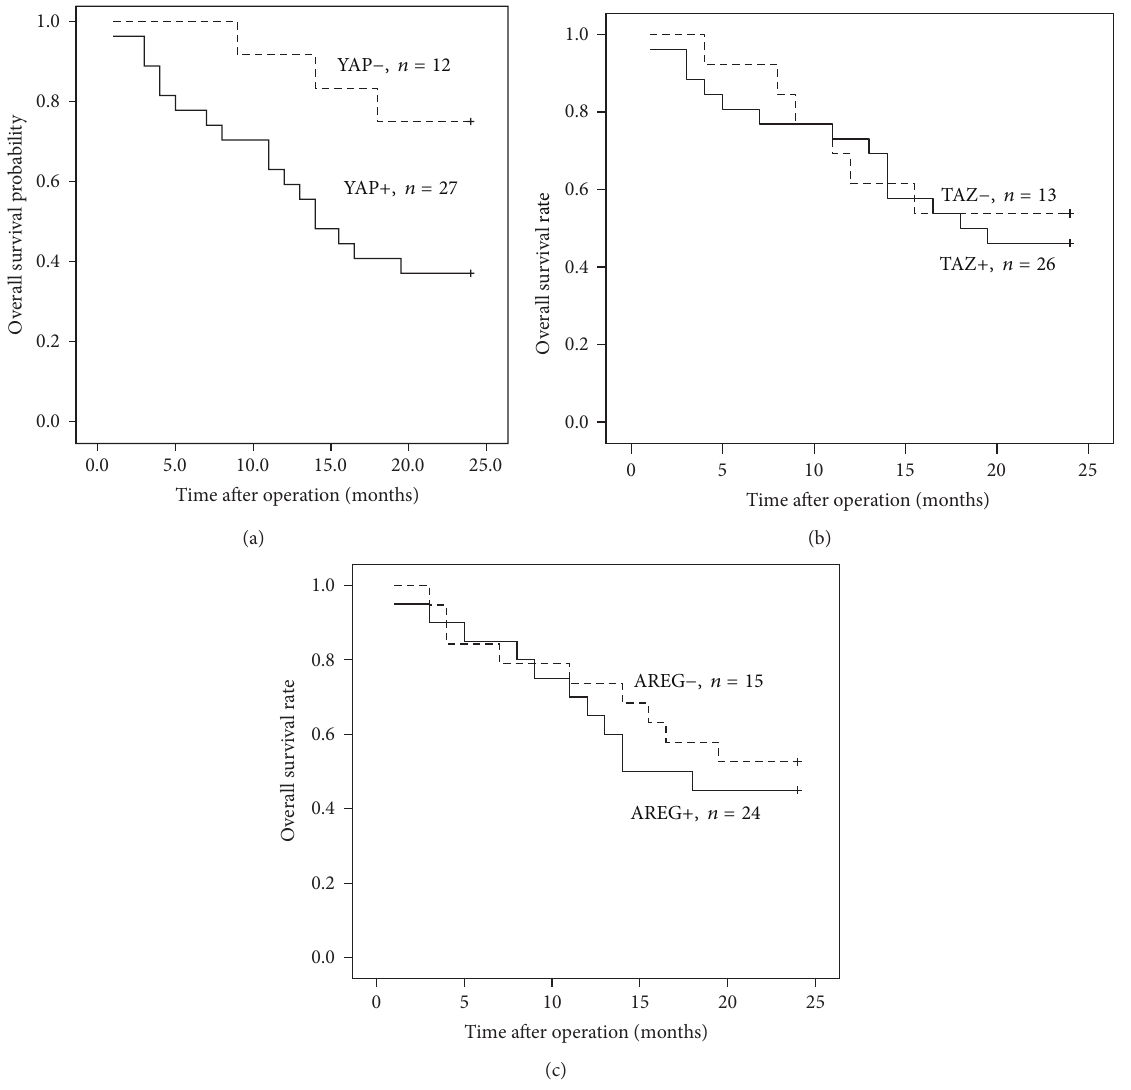
Figure 2: Kaplan-Meier analysis of overall survival (cumulative survival) of HCC patients relative to YAP, TAZ, and AREG expression. (a) Correlation of YAP expression with overall survival of HCC patients; (b) correlation of TAZ expression with overall survival of HCC patients; (c) correlation of AREG expression with overall survival of HCC